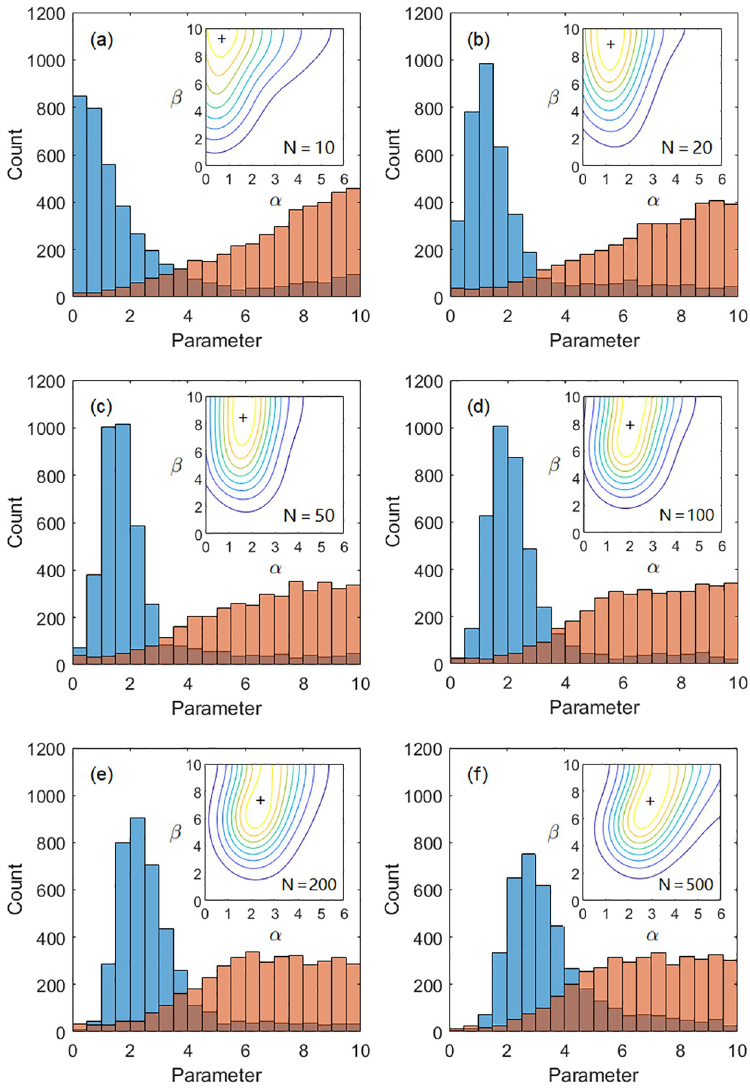
Fig 1. Effects of problem scale on distributions of α , β . Histograms of heuristic parameters α (blue) and β (red) and contour plots of their joint distributions (insets) are plotted for TSP graphs with N = 10, 20, 50, 100, 200, and 500 vertices. The “+” sign marks the mode